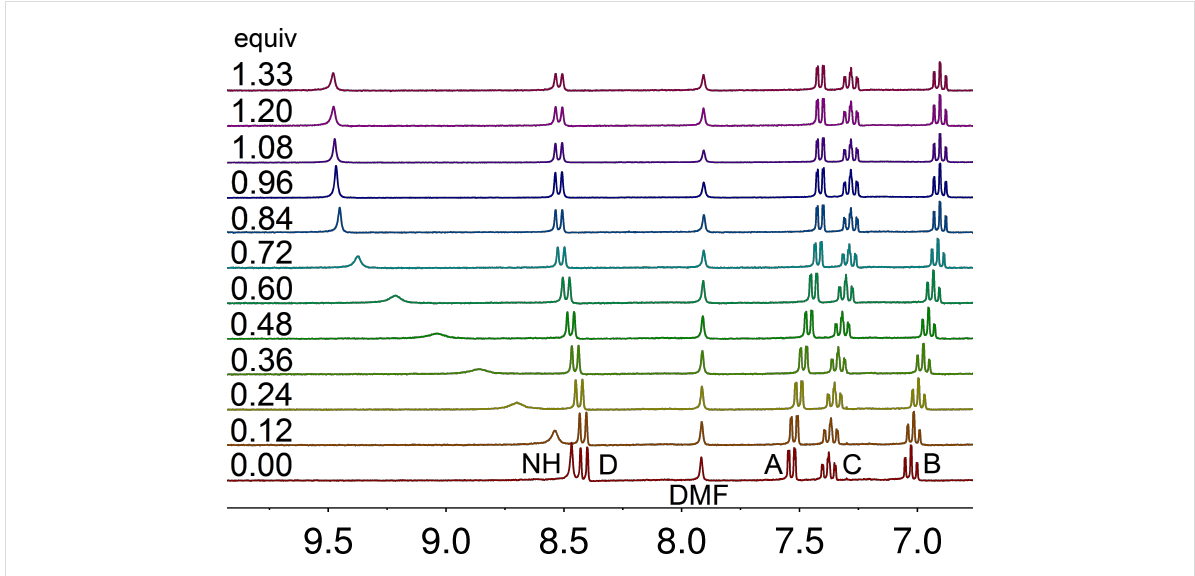
Figure 4: 1 H NMR spectra of 2 in THF- d 8 after addition of increasing molar equivalents of tetrabutylammonium nitrate. The N − H proton resonance shows a distinct downfield shift depending on the concentration of the anion. The small invariant DMF signal originates from the solvent of recrystal- lization used to purify the sample for the NMR experiments.